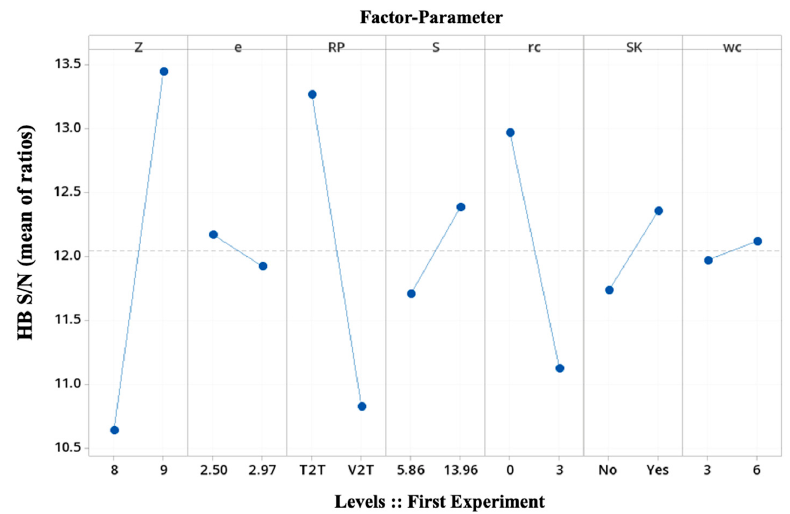
Figure 8. Main effects plot for the first Taguchi experiment (see Table 4).